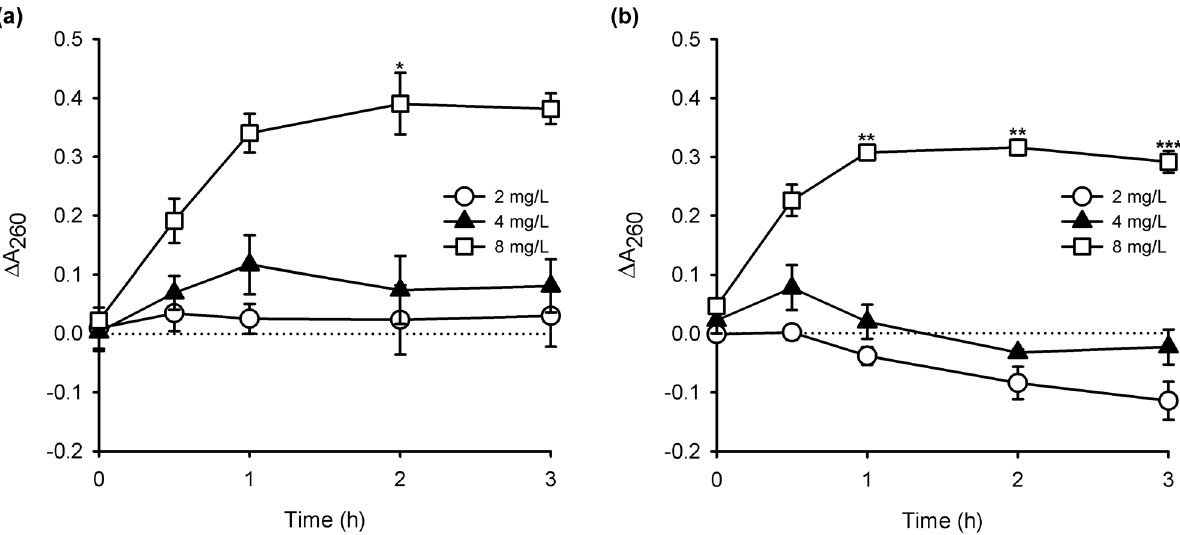
Figure 3. Cytoplasmic Leakage. Change in absorbance at 260 nm ( D A 260 ) MRSA culture supernatants upon treatment with Chlorhexidine (a) and THAM-3 F G (b). Both compounds showed an immediate increase in A 260 within a half hour after treatment at a concentration of 8 mg/L (4 6 MIC). Note that plots represent the difference between the absorbance of the supernatant from non-treated and treated cultures at each time point. *P- value , 0.05, **p-value , 0.01, and ***p-value , 0.001 versus USA300 as analyzed by one-way ANOVA.